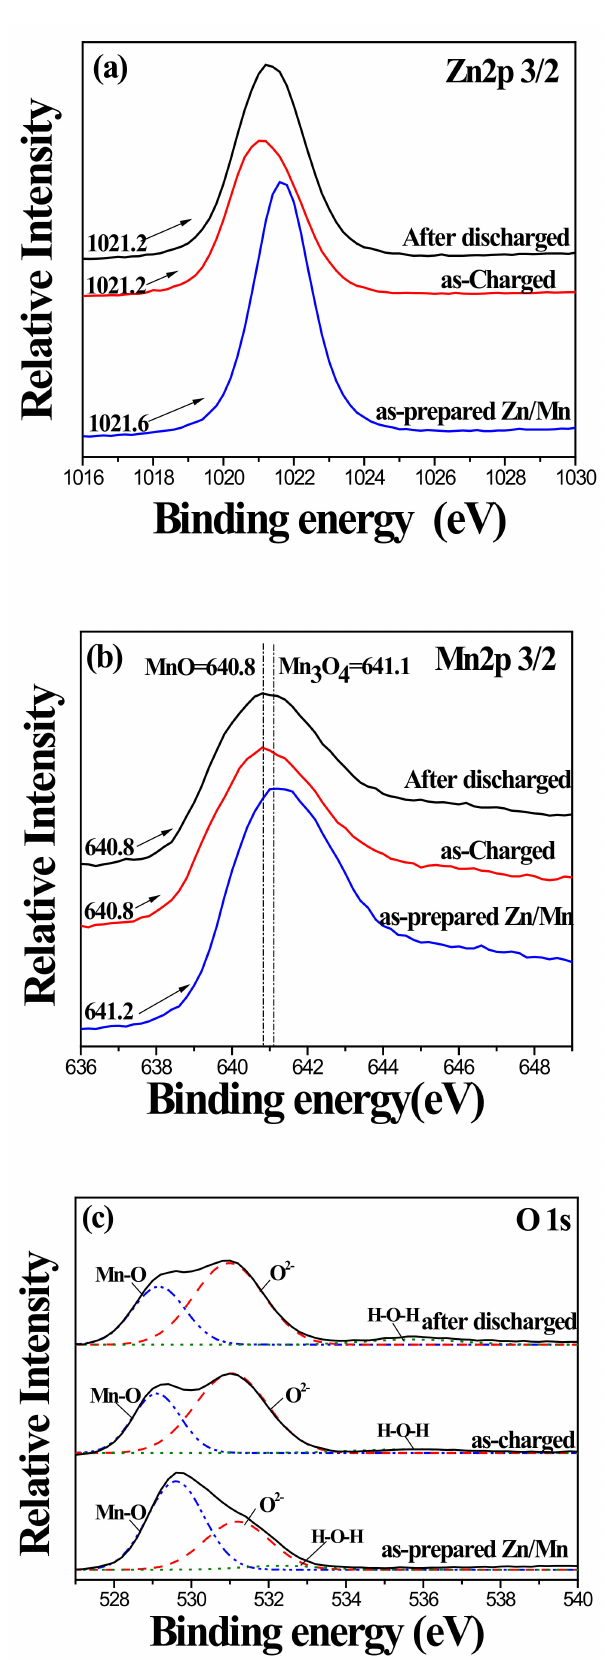
Figure 11. ( a ) Zn 2p 3 / 2, ( b ) Mn 2p 3 / 2 and ( c ) O 1s XPS spectra of MnOx-coated ZnO nanorod before and after CV